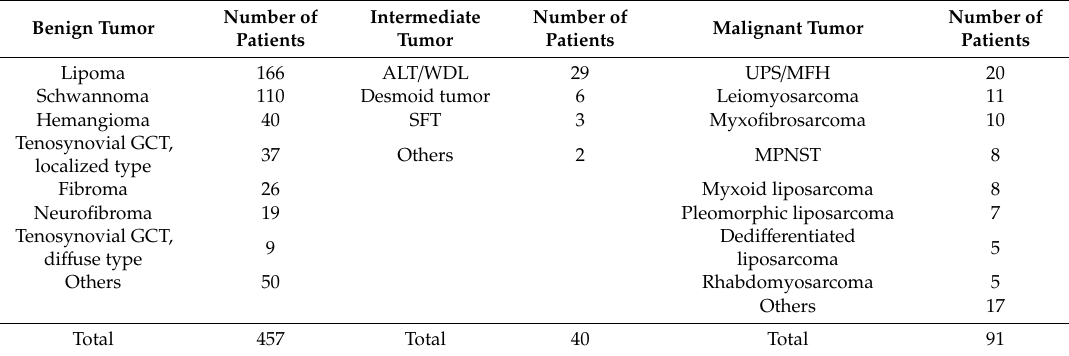
Table 1. Pathologic diagnosis of the 588